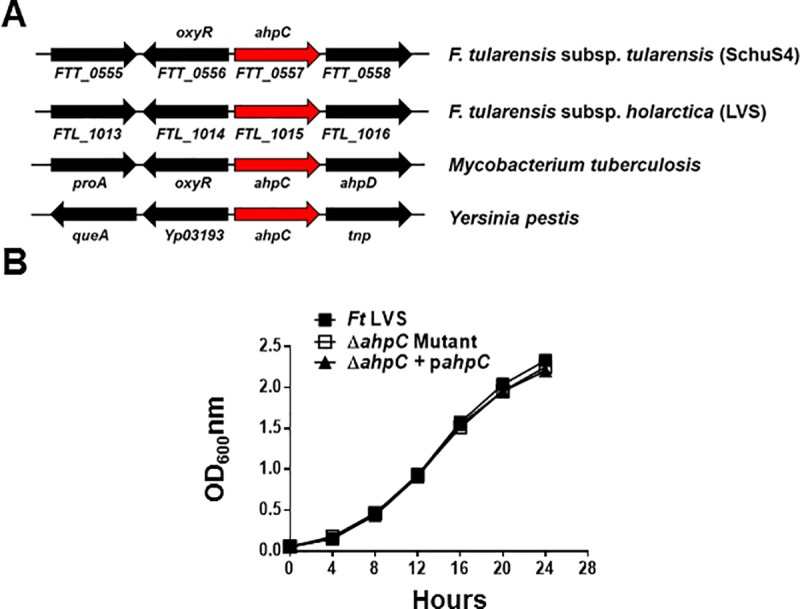
Genomic organization and growth characteristics of the ΔahpC mutant of F. tularensis LVS.(A) Genomic organization of the ahpC gene. (B) Growth curves of F. tularensis LVS, the ΔahpC mutant and the transcomplemented strains (ΔahpC + pahpC). Equal numbers of bacteria were suspended in Mueller-Hinton broth, and the optical densities (OD600) were recorded every 4 hours.